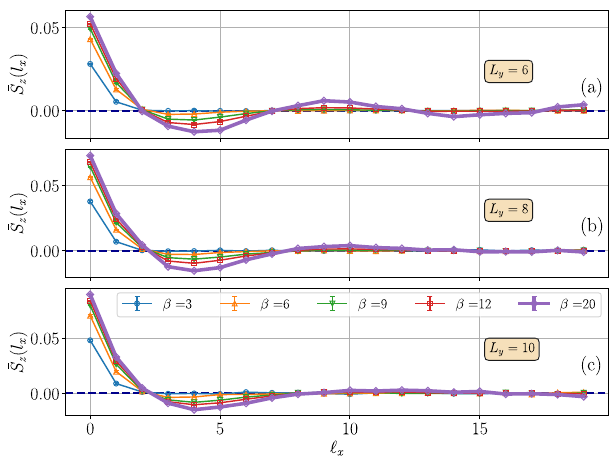
FIG. 9. Investigating the behavior in the TDL at δ ¼ 1 = 5 ( U ¼ 6 ). Rung-averaged staggered spin density S z ð l x Þ is plotted versus site l x on cylinders with fixed length L x ¼ 20 and varying width. Staggered pinning fields with amplitude v ¼ 0 . 1 are applied to the left edge, at ð l x ¼ 0 Þ . The three widths (a) L y ¼ 6 , (b) L y ¼ 8 , and (c) L y ¼ 10 , respectively. Converged results obtained from the self-consistent procedure are plotted at each temperature. Error bars are smaller than the symbol